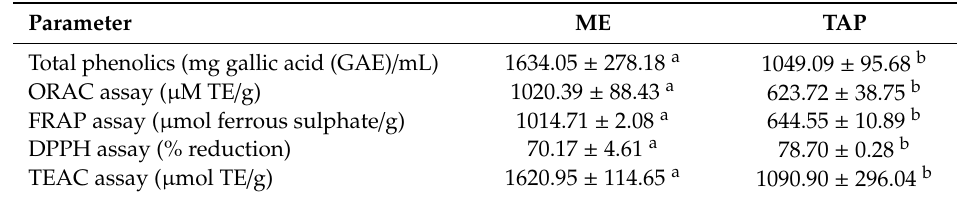
Table 1. Total phenolic content and antioxidant potential of ME and TAP evaluated by di ff erent assays.